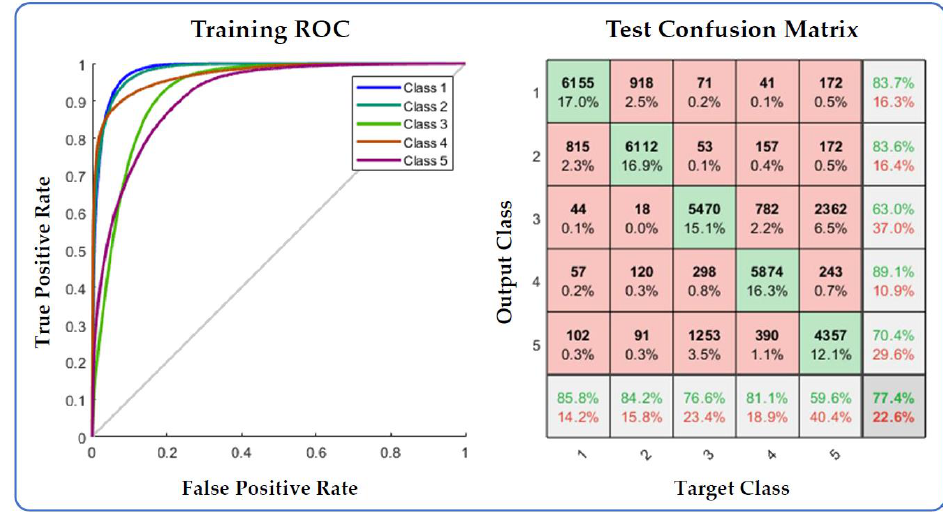
Figure 8. Phase 3 — Model 10 of 12 models: 2.5 pps, post-stimulation (Slots 6 – 8), comparing five classes (EEG Delta, Theta, Alpha, Beta and Gamma bands). For this model, the train-to-test ratio was approximately 5:1, with kappa = 0.718, area under the ROC curve (AUC) = 0.786 and F-measure = 0.777.